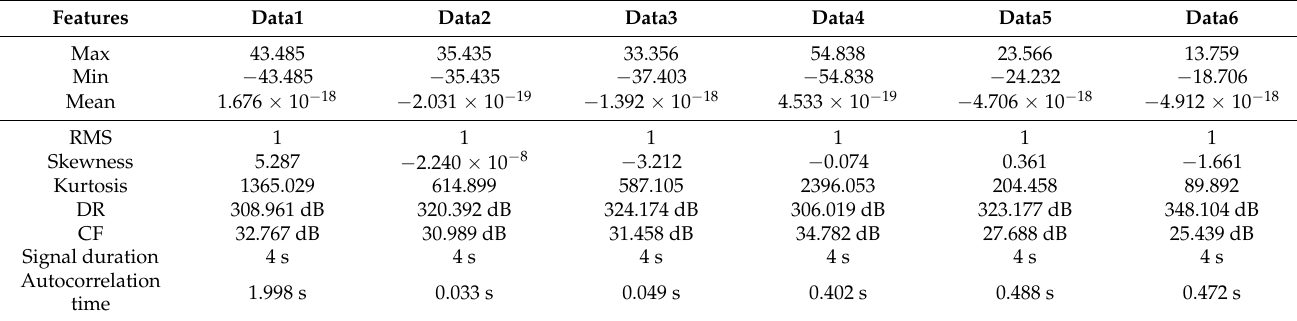
Table 1. Feature parameter of Dataset 1.